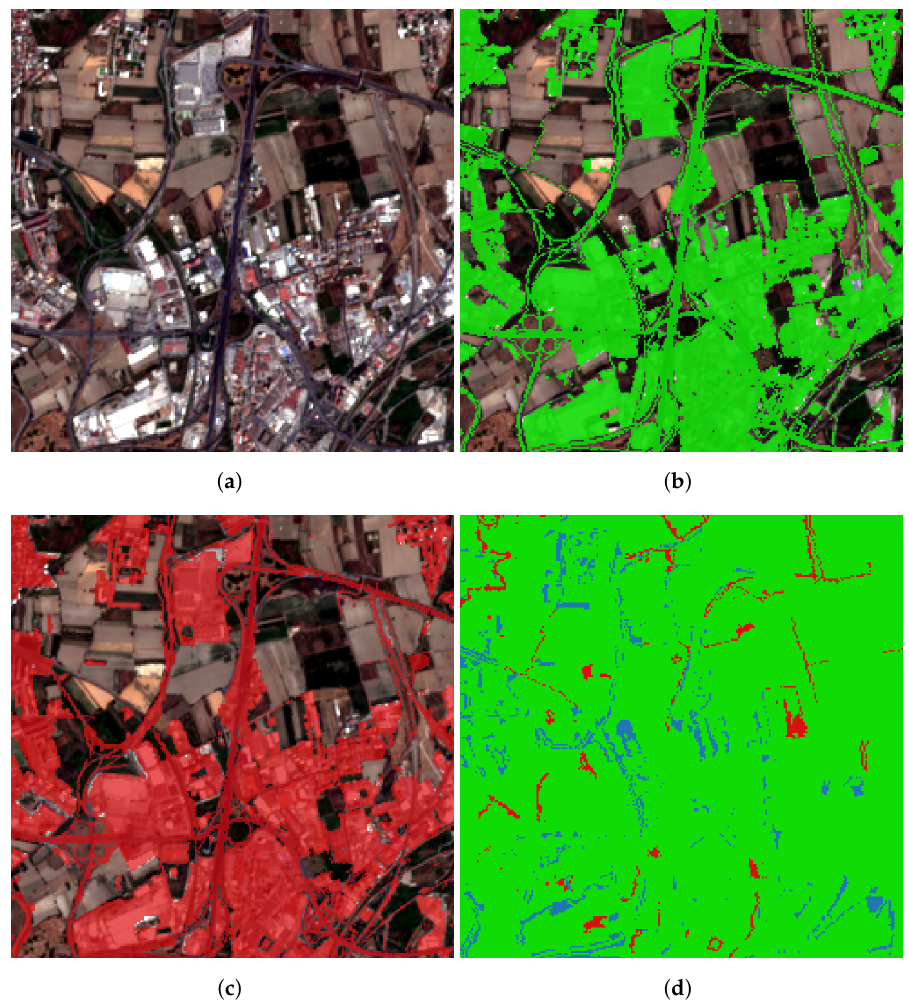
Figure 11. Example of an imperviousness mask obtained using ReFuse. Top left is the considered path (only RGB bands have been reported for visualization reasons). Top right is the corresponding ISPRA Ground Truth. Bottom left is the imperviousness mask obtained by the proposed ReFuse architecture. Bottom right is the ReFuse segmentation errors. ( a ) RGB patch. ( b ) Ground truth. ( c ) ReFuse. ( d ) Error mask: FP (blue), FN